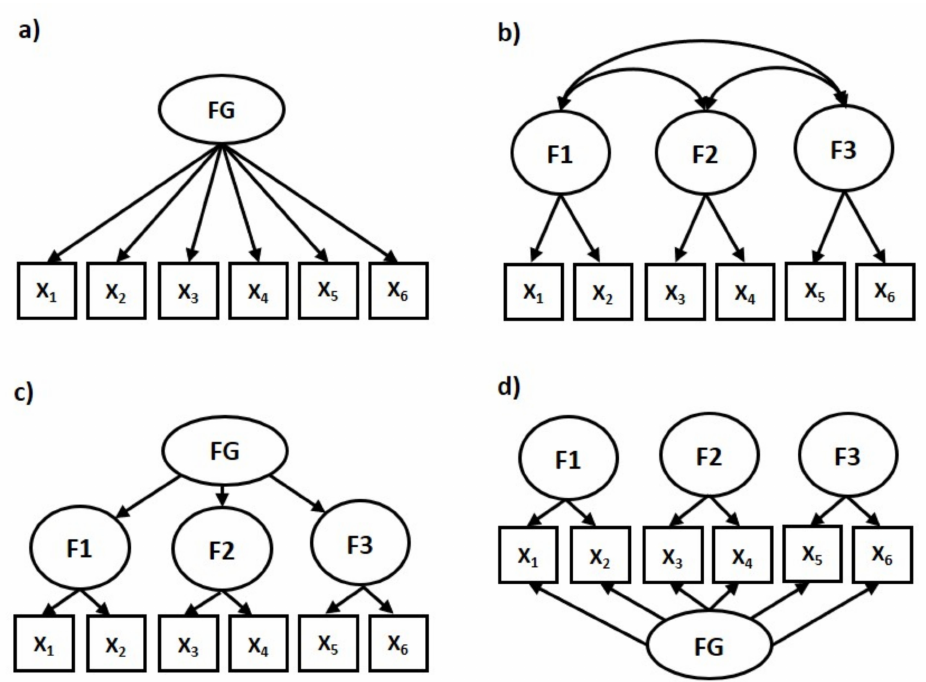
Figure 1. Hypothetical models of factor analysis: ( a ) One-factor; ( b ) Three-factor; ( c ) Second-order factor; ( d ) Bi-factor. FG = general factor, X 1 –X 6 = Items; F1–F3 = factors. Latent (factor) variables are represents by ovals, while observed (measured) variables are represented by